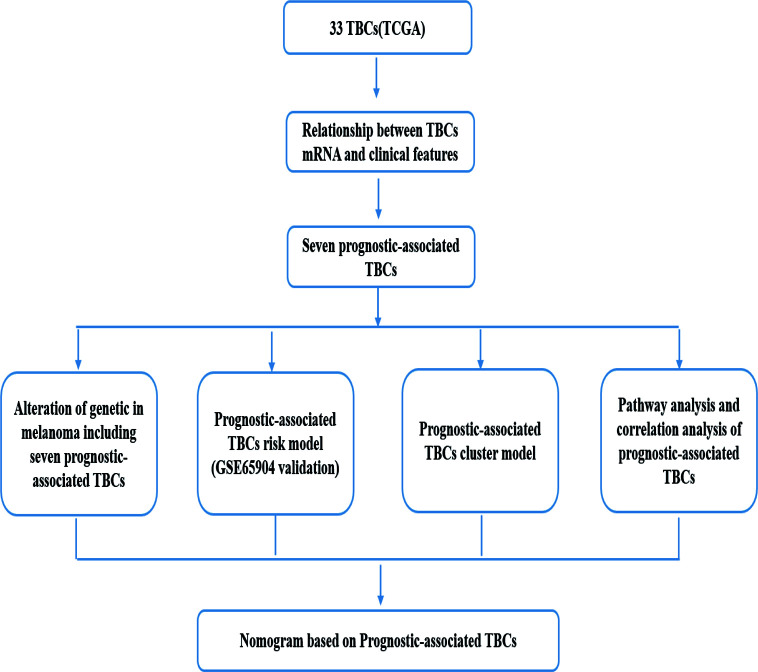
A flowchart designed for the study.